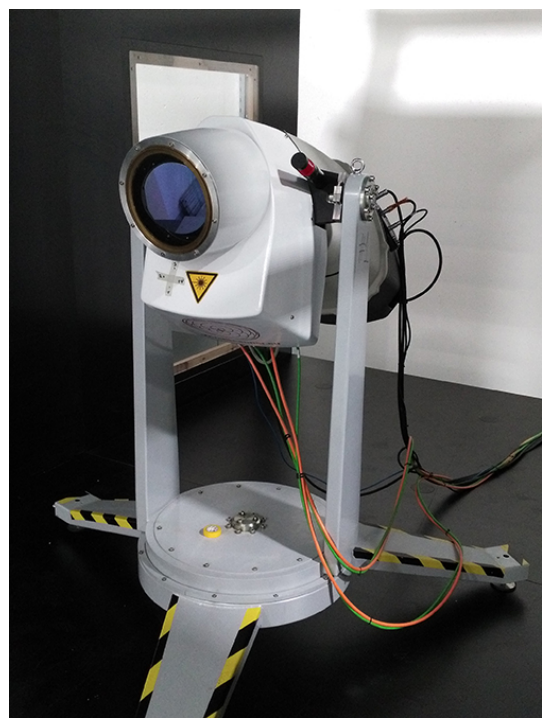
Figure 3. One of the two short-range WindScanners in the wind